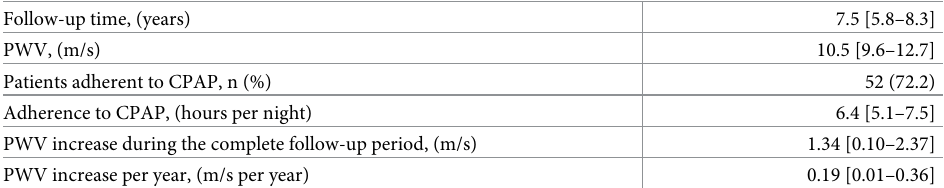
Table 2. Data at the follow-up PWV